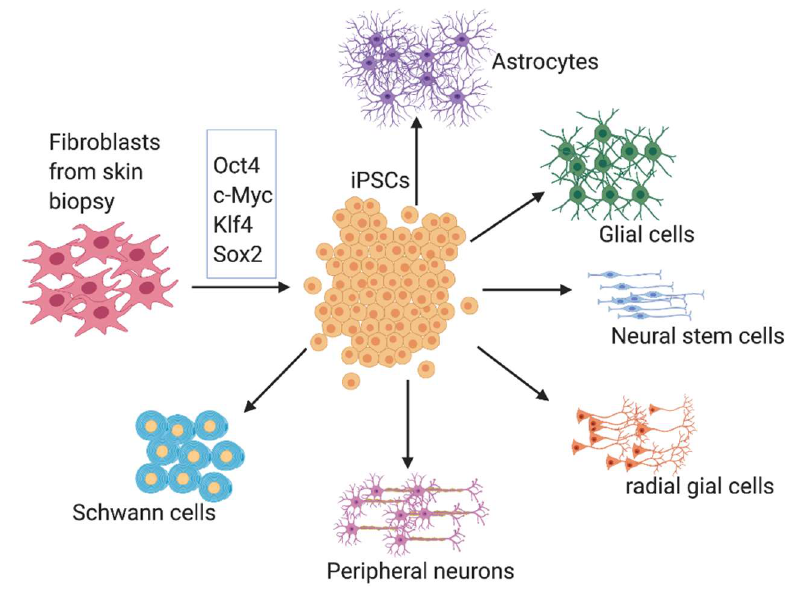
Figure 3. iPSCs serve as a potential source of cellular component for bioprinting. Adult somatic cells collected from peripheral tissues can be de-differentiated to iPSCs. iPSCs can differentiate into different types of cells such as peripheral neurons, radial glial cells, neural stem cells, glial cells and